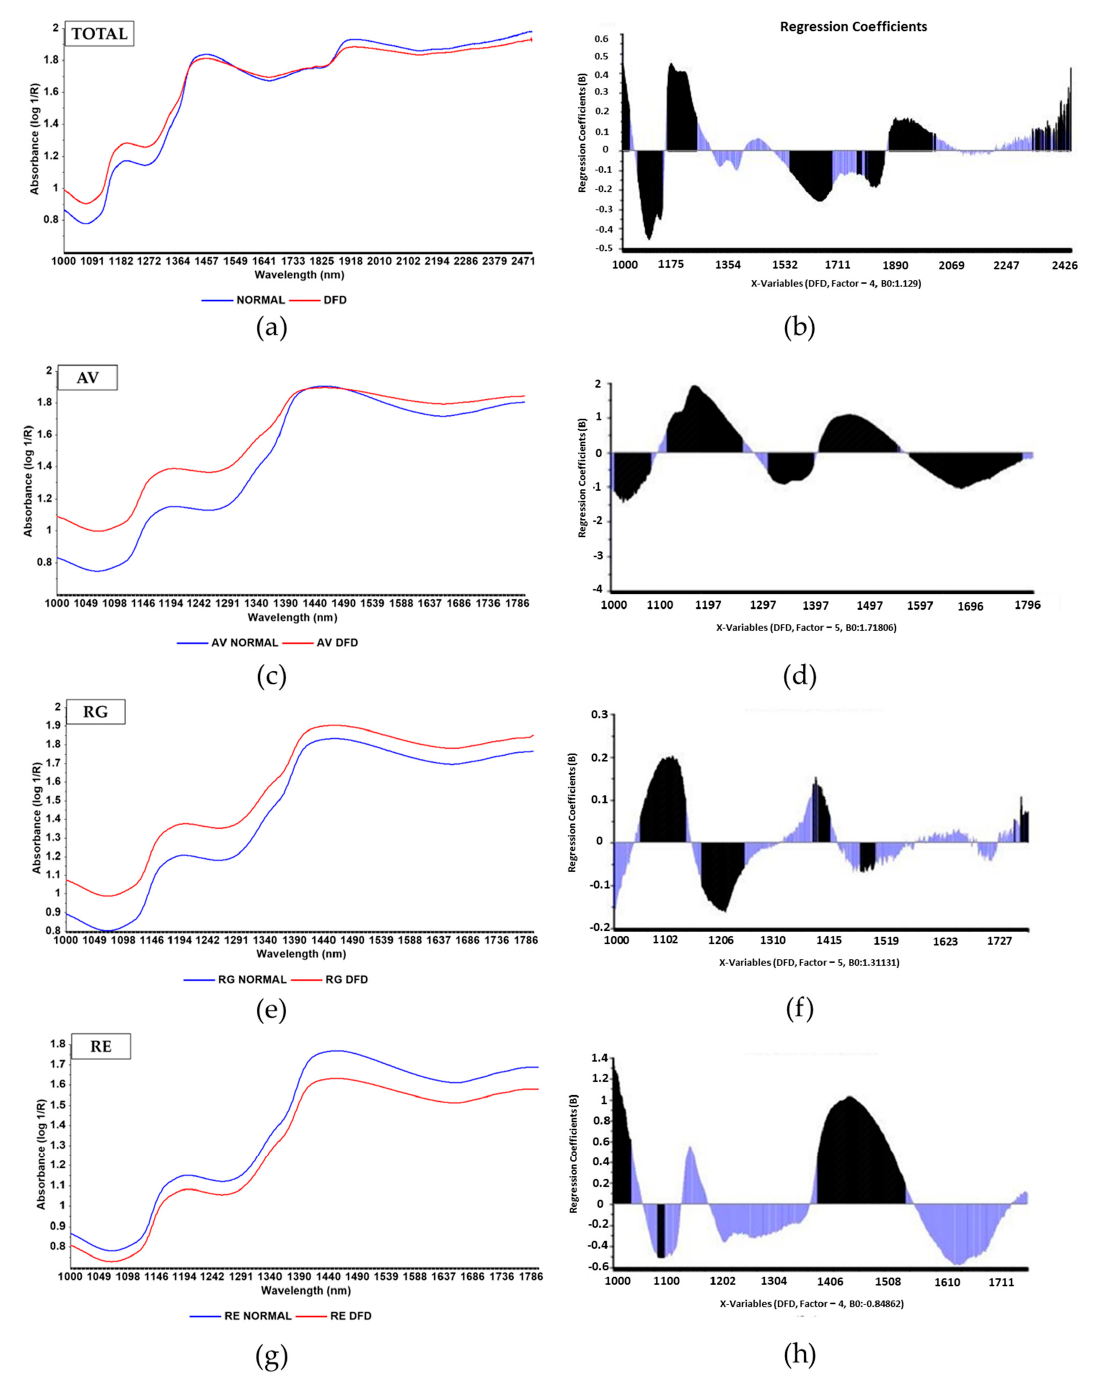
Figure 3. Left: Mean absorbance (log 1/R) spectra of Normal (blue) and DFD (red) meat samples from: ( a ) Total sample set after averaging 110 Normal and 18 DFD spectra (1000–2500 nm); ( c ) pure- breed Asturiana de los Valles (AV) after averaging 43 Normal and 7 DFD spectra (1000–1800 nm); ( e ) purebreed Rubia Gallega (RG) after averaging 30 Normal and 7 DFD spectra (1000–1800 nm); and ( g ) purebreed Retinta (RE) after averaging 40 Normal and 4 DFD spectra (1000–1800 nm). Right: PLS-DA analysis after absorbance (log1/R): graphical representation of regression coefficients (B) of wavelengths in DFD meat spectra data from: ( b ) total (1000–2500 nm), ( d ) AV (1000–1800 nm); ( f ) RG (1000–1800 nm), and ( h ) Retinta (1000–1800 nm) sample sets. Significant variables are highlighted in